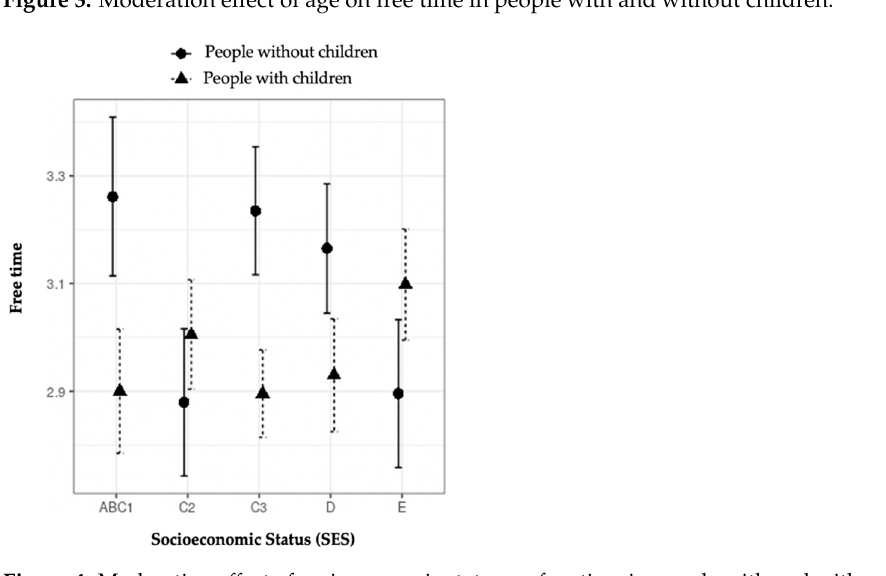
Figure 4. Moderation effect of socioeconomic status on free time in people with and without chil- dren.